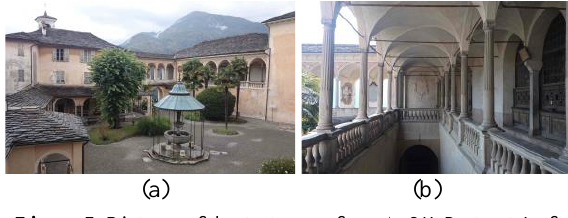
Figure 5. Pictures of the test scene from ArCH Dataset. Left: “B_SMV_chapel_27to35 south side”. Right: “B_SMV_chapel_27to35 indoor part” Copyright © 2022 ArCH Dataset). Figure 6. Qualitative outcomes for semantic segmentation of “B_SMV_chapel_27to35” while training with a single scene from the ArCH Dataset. From left to right: ground truth (a), the prediction of training from the scratch pipeline (b), and the result obtained by the pre-training pipeline (c).